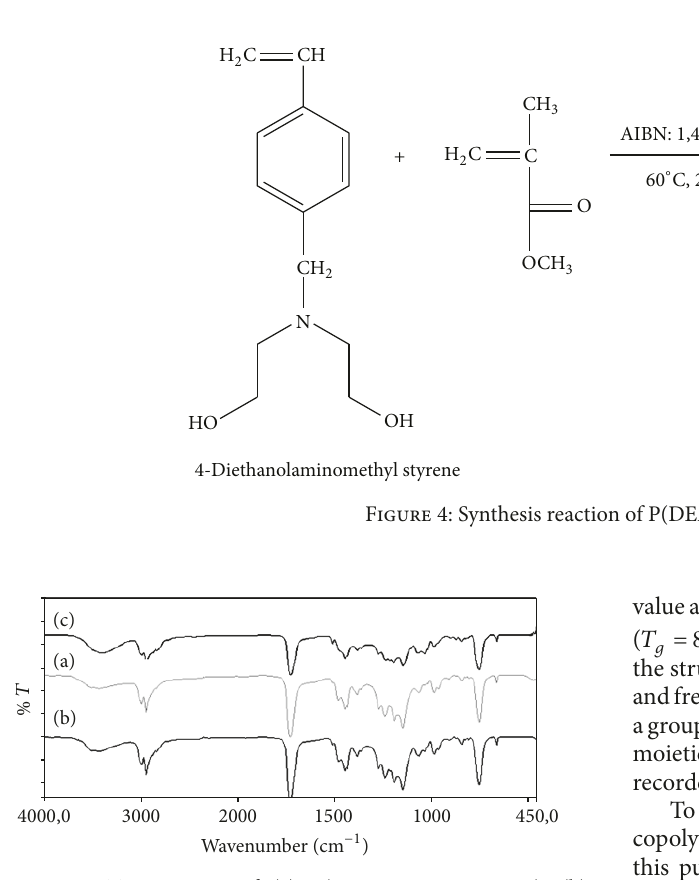
Figure 5: FT-IR spectra of (a) P(DEAMSt0.11-co-MMA), (b) P(DEAMSt0.19-co-MMA), and (c) P(DEAMSt0.30-co-MMA). Table 1: The average molecular weights and polydispersities of